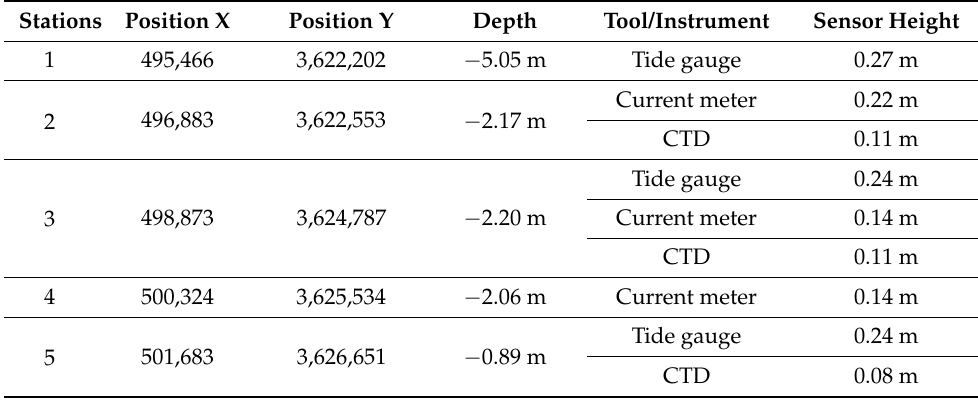
Figure 2. Orthophoto, 42 sampling stations [26], transects distribution (A, B, C), SGD locations [2] and tide gauges positions (1–5). Table 1. Stations spatial distribution, depth, and measurements instruments for harmonic analysis (Source DPDPM/MET, 2012).